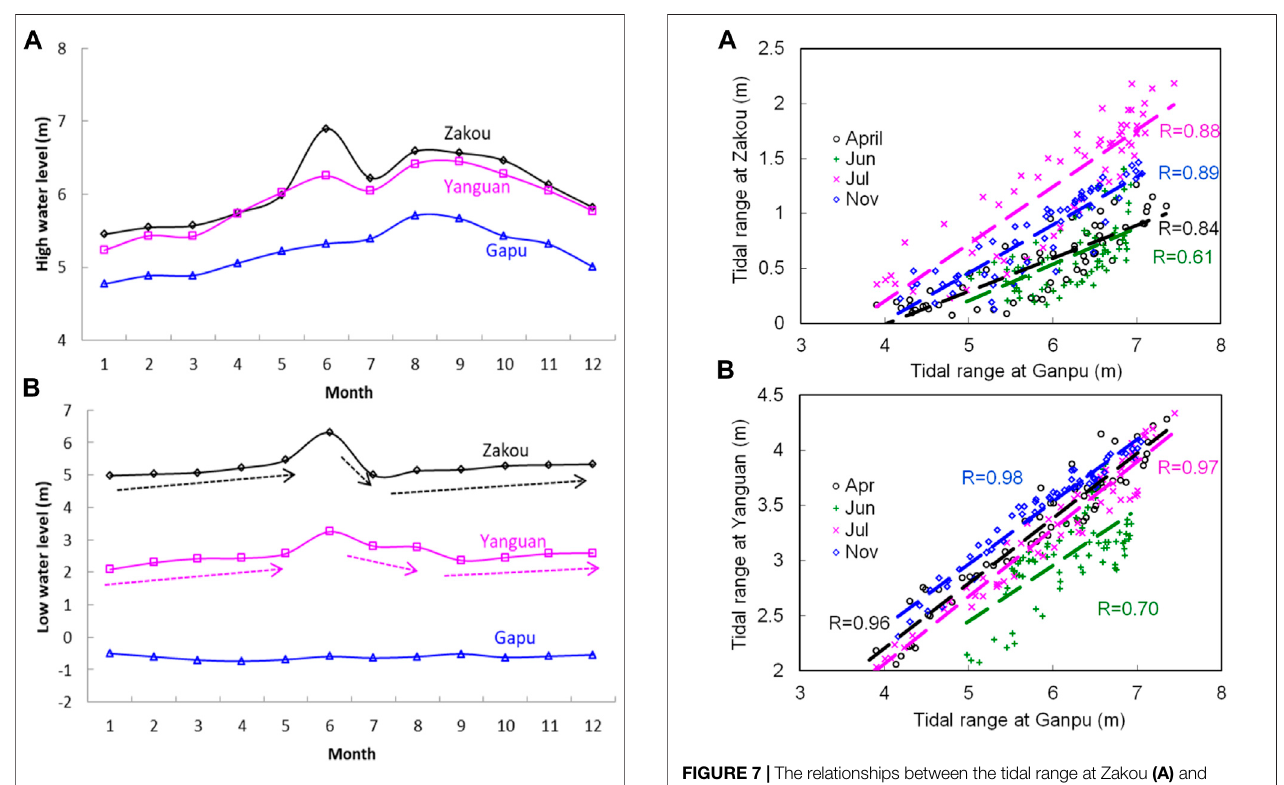
Frontiers in Earth Science |